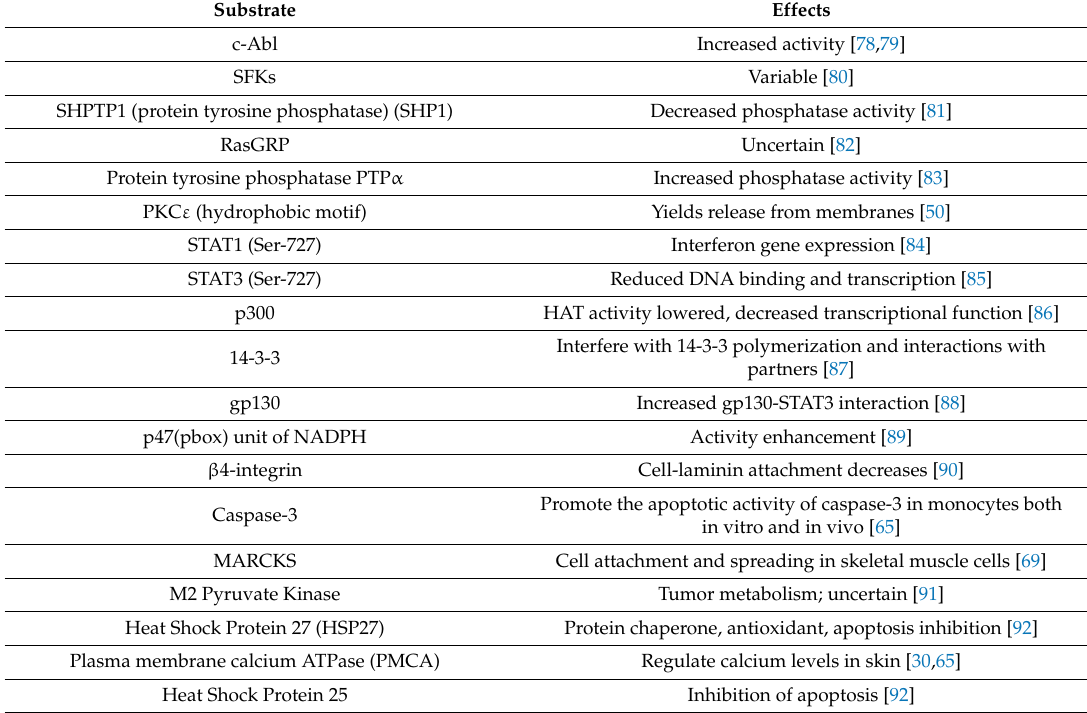
Table 1. PKC δ substrates and functions. Adapted from Steinberg 2004